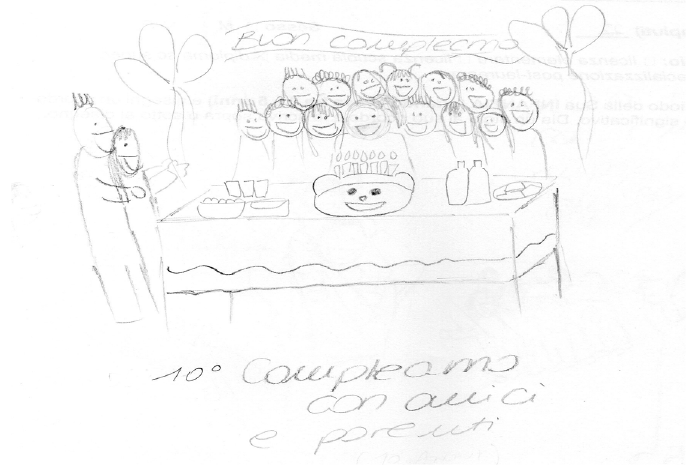
Figure 2. Drawing, referring to childhood, entitled “My tenth birthday with my friends and family”.